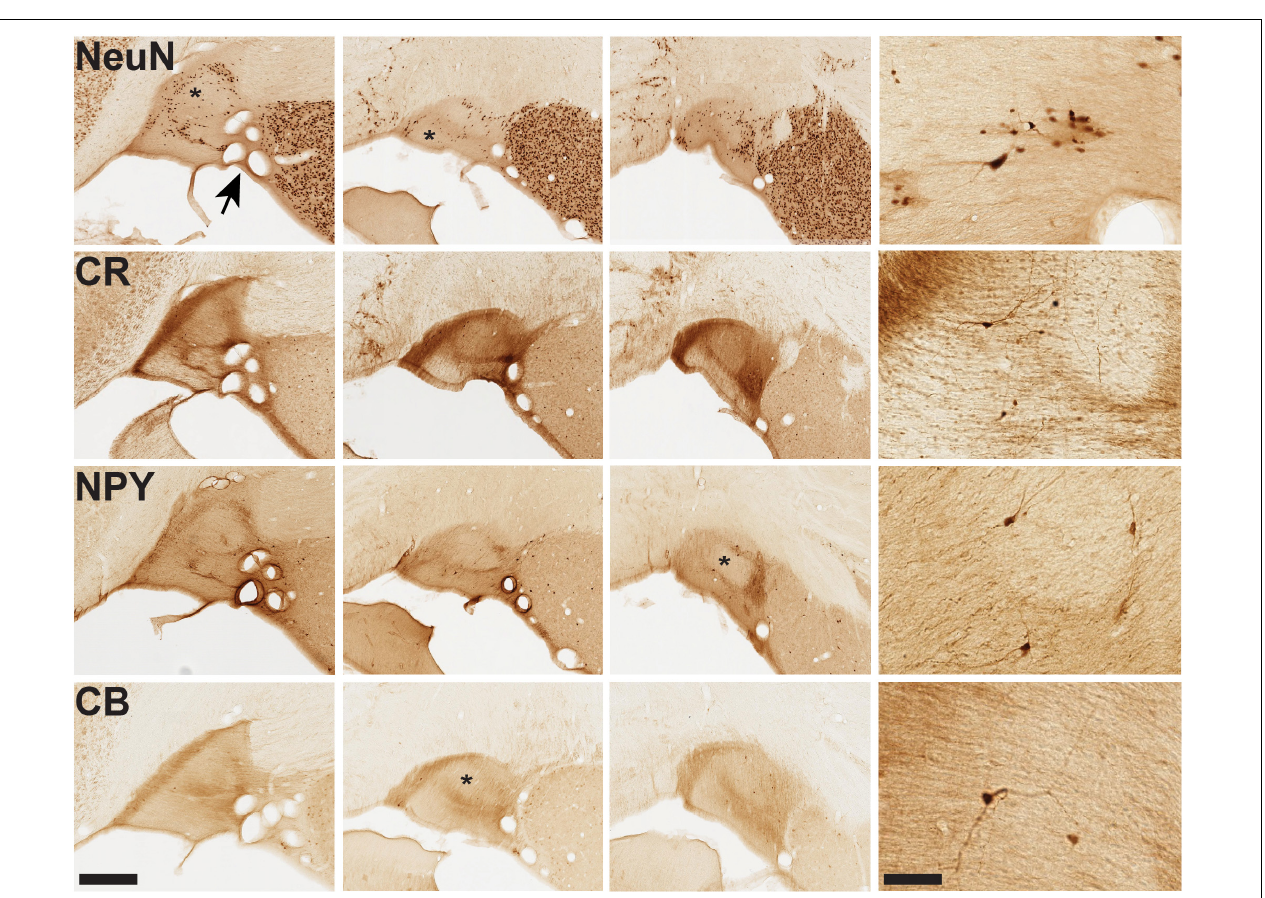
FIGURE 3 | Microstructural features of vST from infant brain B61. For the four markers shown, closely adjoining sections are illustrated from three AP coronal levels, anterior (at left) to posterior (at right). Immunohistochemistry (IHC) for NeuN demonstrates pan-neuronal distribution, while IHC for CR, NPY, and CB reveals smaller subpopulations of neurons together with neuropil. Distinct fiber bundles are evident at the medial edge of vST (at the left). Conspicuous “hollows,” as visualized by these markers, are indicated by an asterisk in several of the images. Arrow at upper left image (NeuN) points to a cluster of coronally sectioned blood vessels, visible throughout. Representative fields of neurons are illustrated for each marker in the higher magnification panel at the far right. Scale bars = 400 (left) and 50 µ m